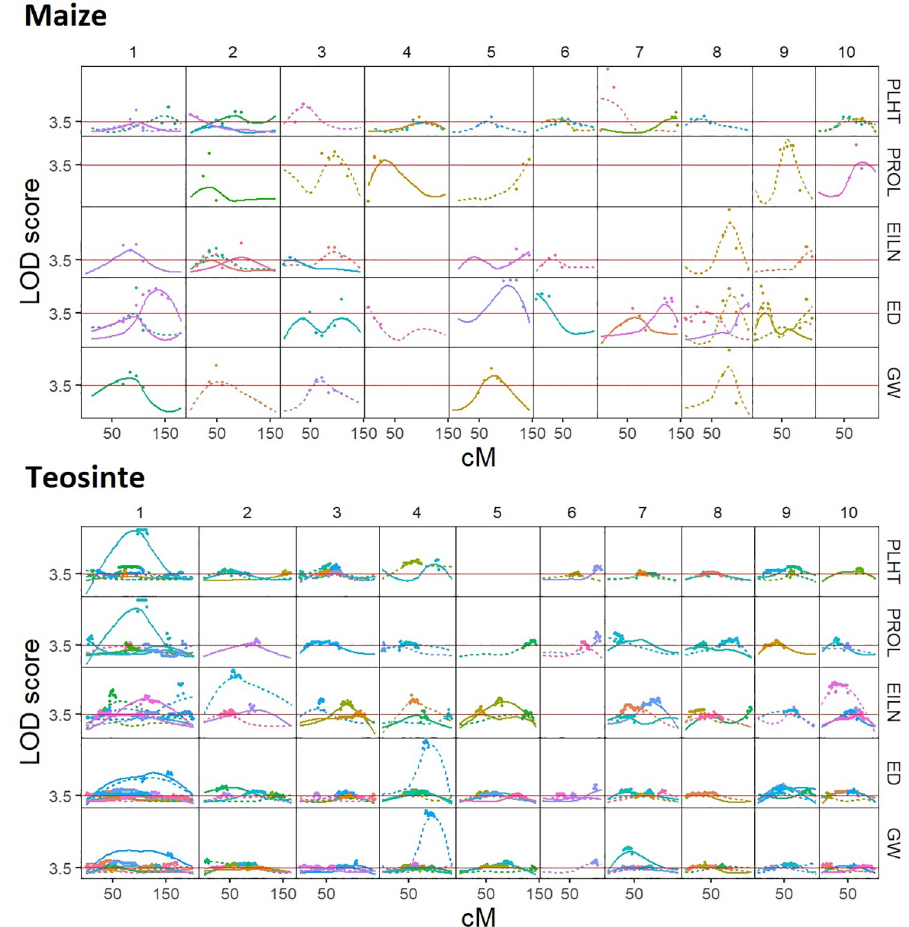
Fig 5. Rare allele linkage scan for five traits in maize landrace and teosinte populations. Each column represents one chromosome; linkage map cM positions are displayed on the x-axis. Each row represents LOD scores of linkage scan for one trait. Each founder parent is represented by a different color and the two different haplotypes of each parent are distinguished by solid vs. dashed lines. Red solid line indicates the whole-genome LOD significance